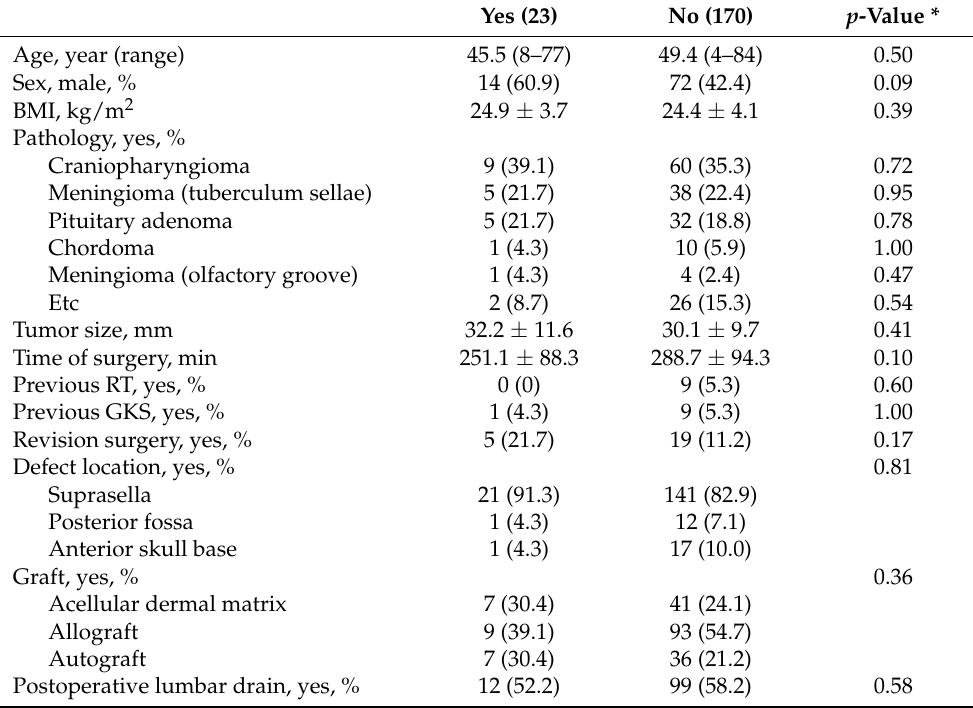
Table 3. Comparison of various factors according to postoperative CSF leak (Univariate